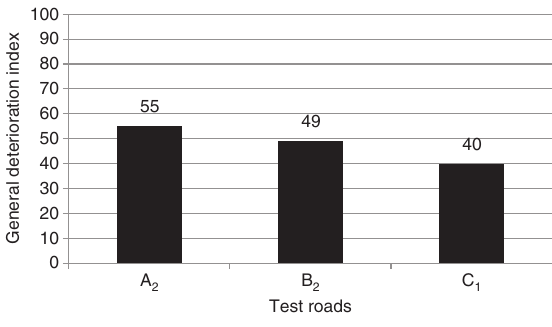
Figure 2: General deterioration index of test roads.